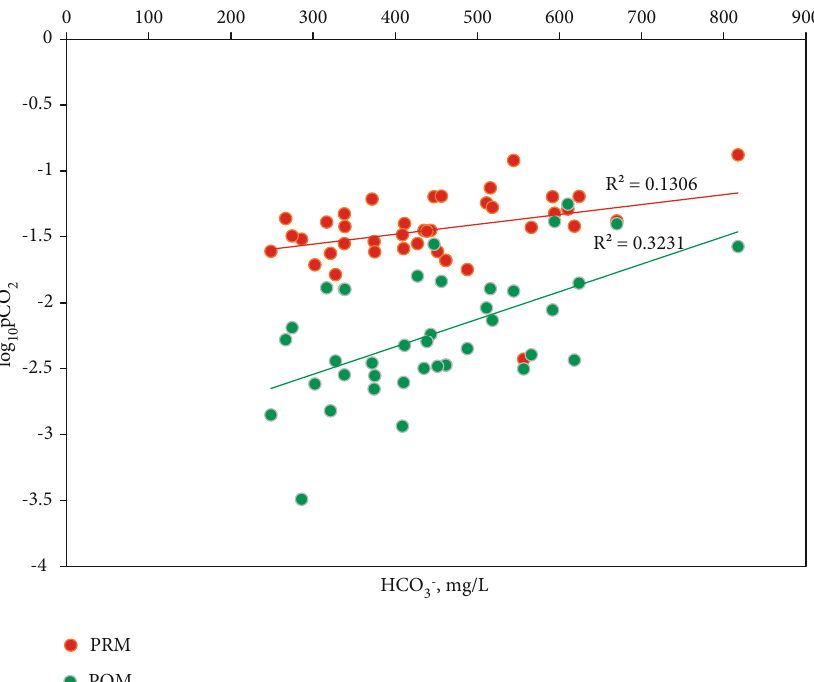
( p CO ) in groundwater. 10 2